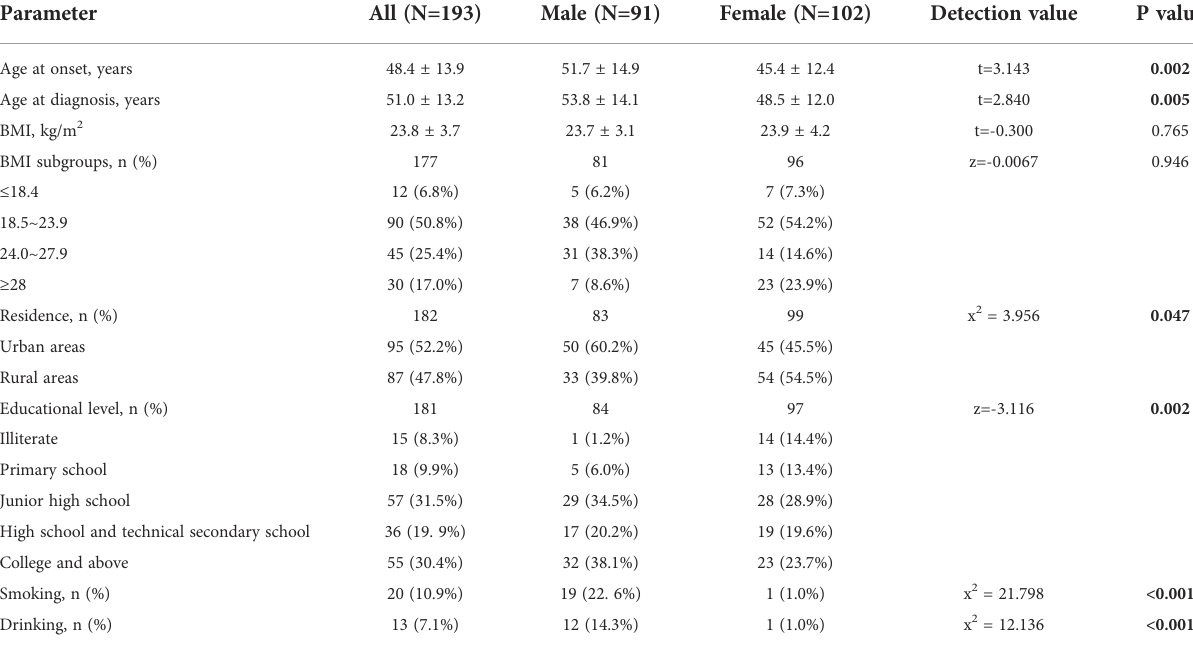
TABLE 1 Comparison of basic characteristics between different